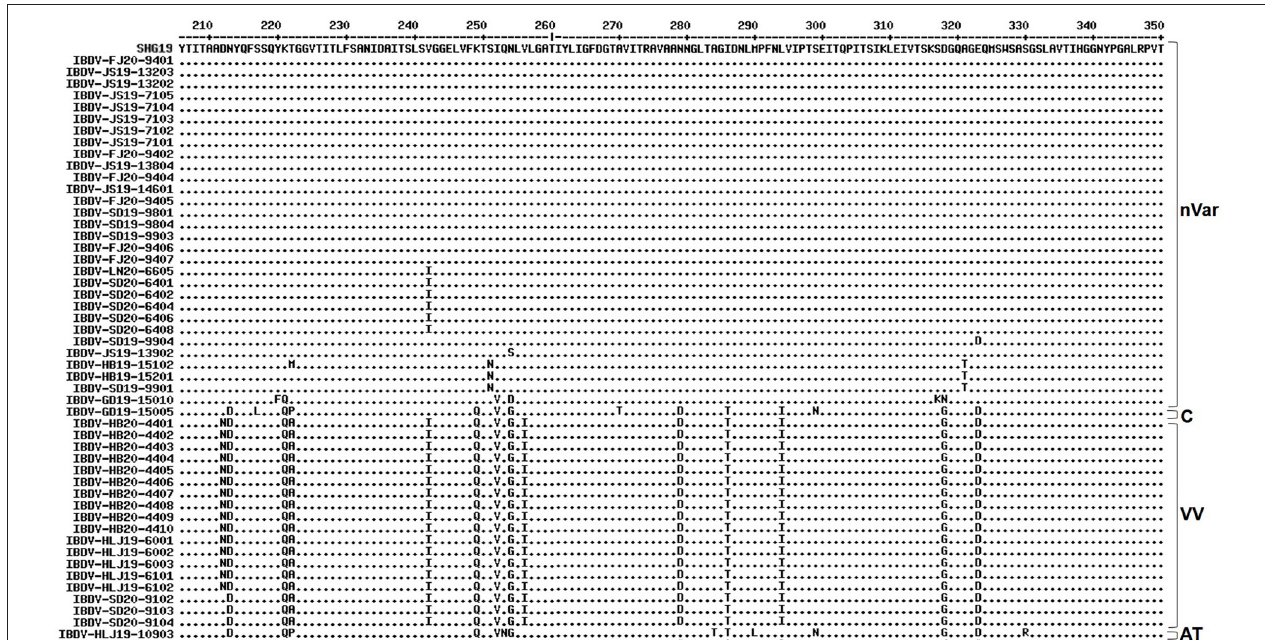
FIGURE 2 | Amino acid substitution in the VP2 hypervariable region of the 50 strains detected in this study in comparison with the novel variant reference strain SHG19 (GenBank no. MH879092). Identical residues in aligned sequences were indicated by dots and differences were indicated by single letters. nVar, novel variant strain; C, classical strain; VV, very virulent strain; AT, attenuated